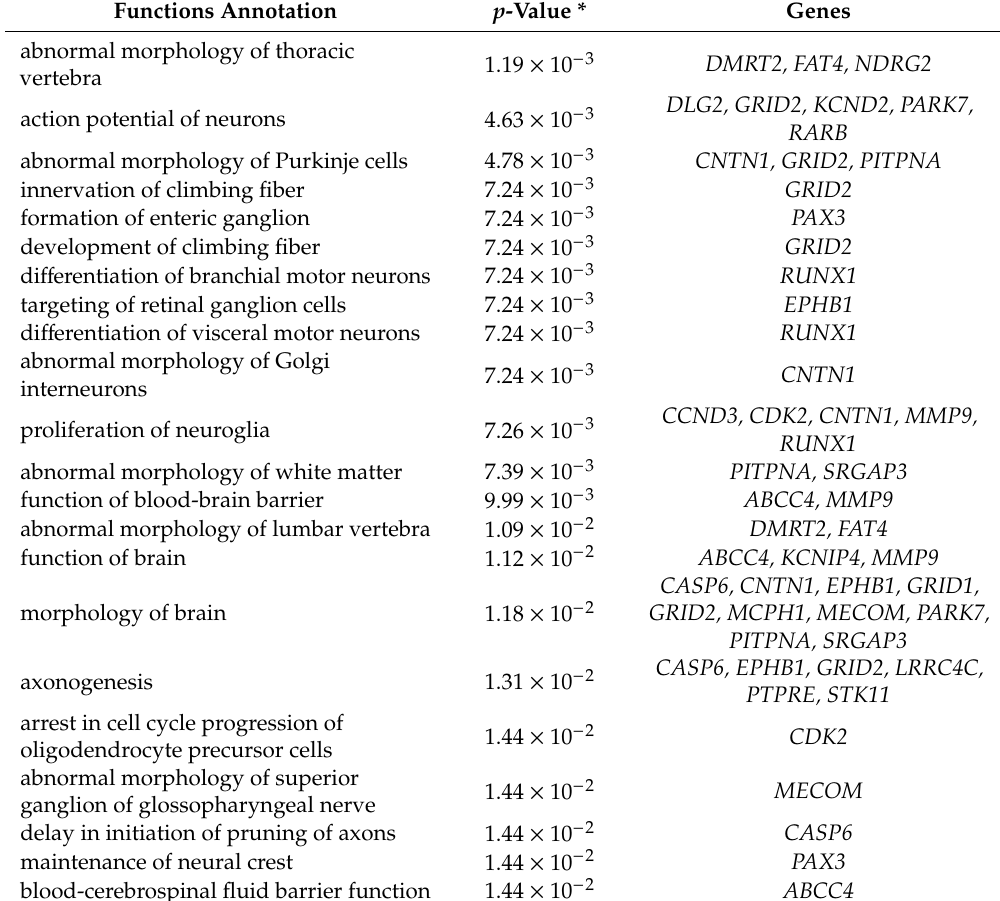
Table 7. Neurological functions associated with genes implicated by social skills